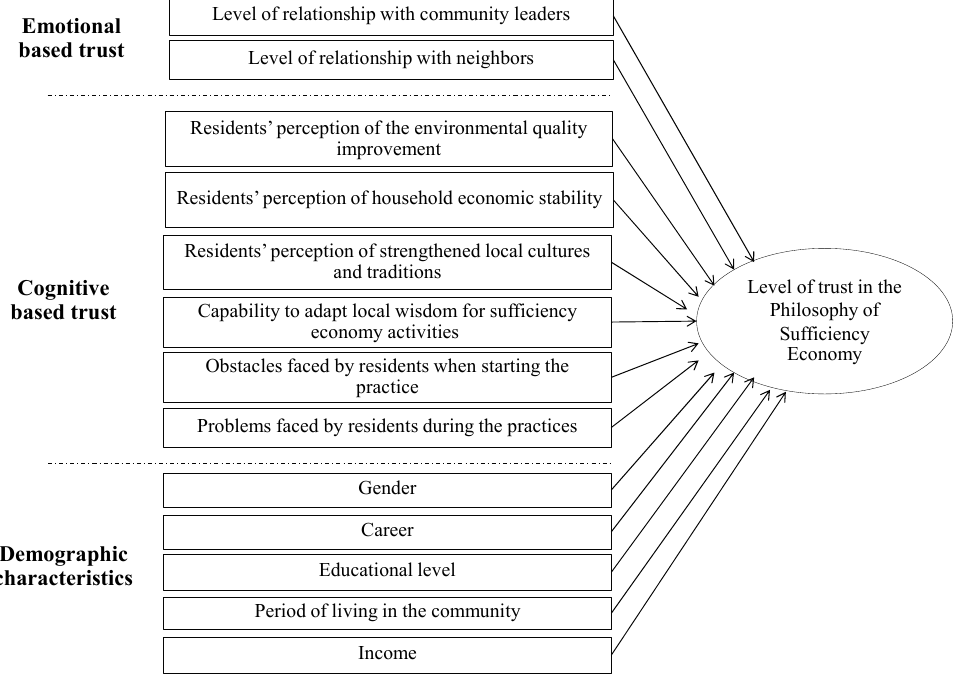
Figure 1. Study Framework.